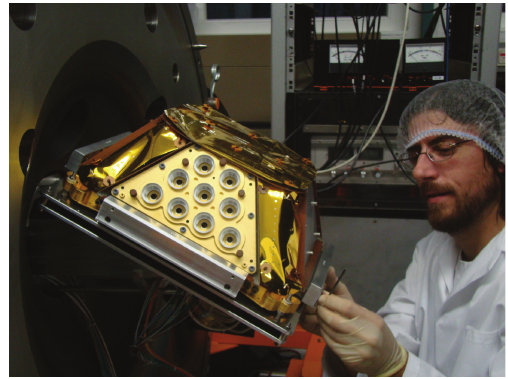
Figure 7: LISA pathfinder thruster installed in vacuum